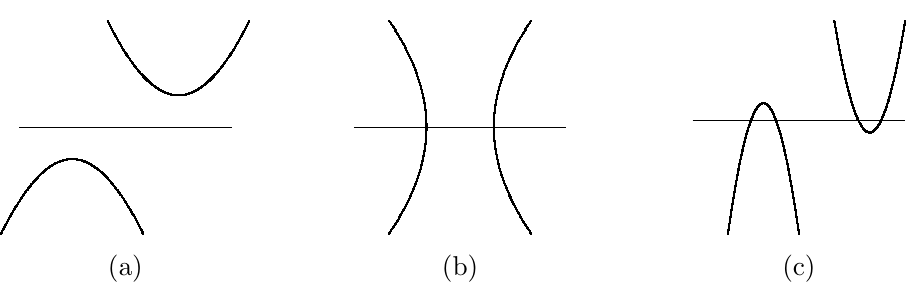
Figure 6 . Possible form of the singular loci of the propagator carrying momentum ‘ in the ‘ 1 plane. The thin horizontal lines denote real ‘ 1